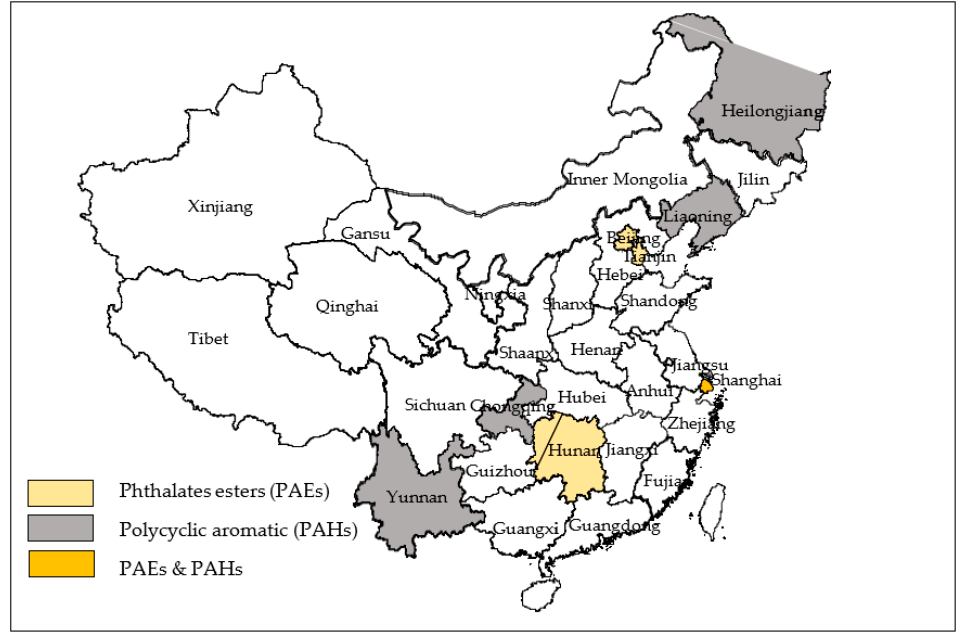
Figure 2. The locations of all studies on health effects of SVOCs in China.